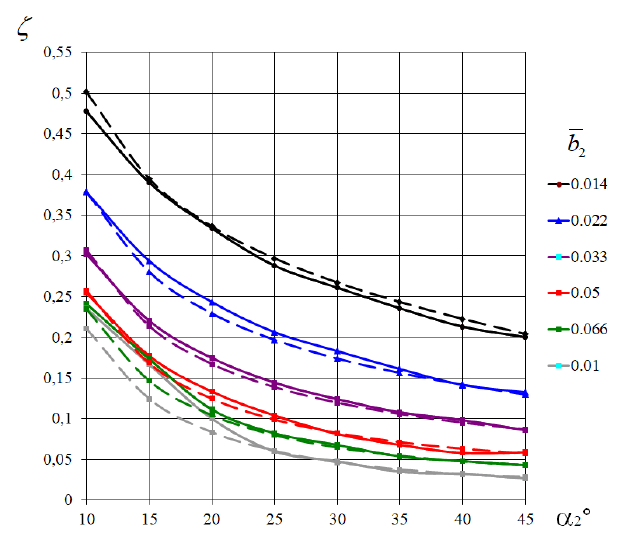
Figure 7. VLD loss coe ffi cients with di ff erent relative widths. D 4 = 1.6, λ c 2 = 0.64 and Re D 2 = 9.2 · 10 6 . Solid line—ANSYS CFX, dotted line—approximation.